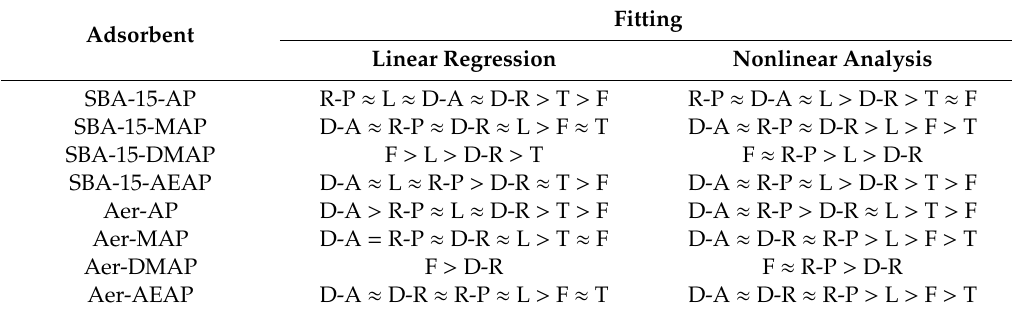
Table 7. Isotherm model